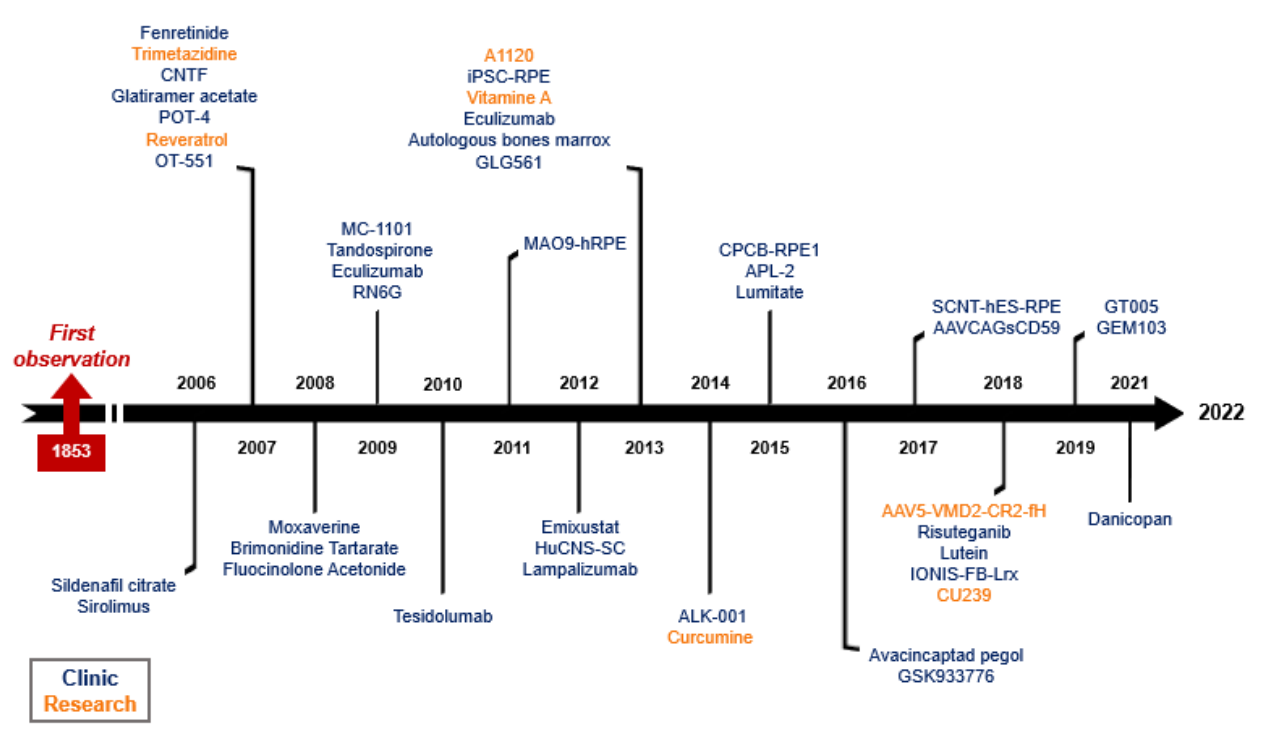
Figure 11. Timeline of therapeutic agents developed against atrophic